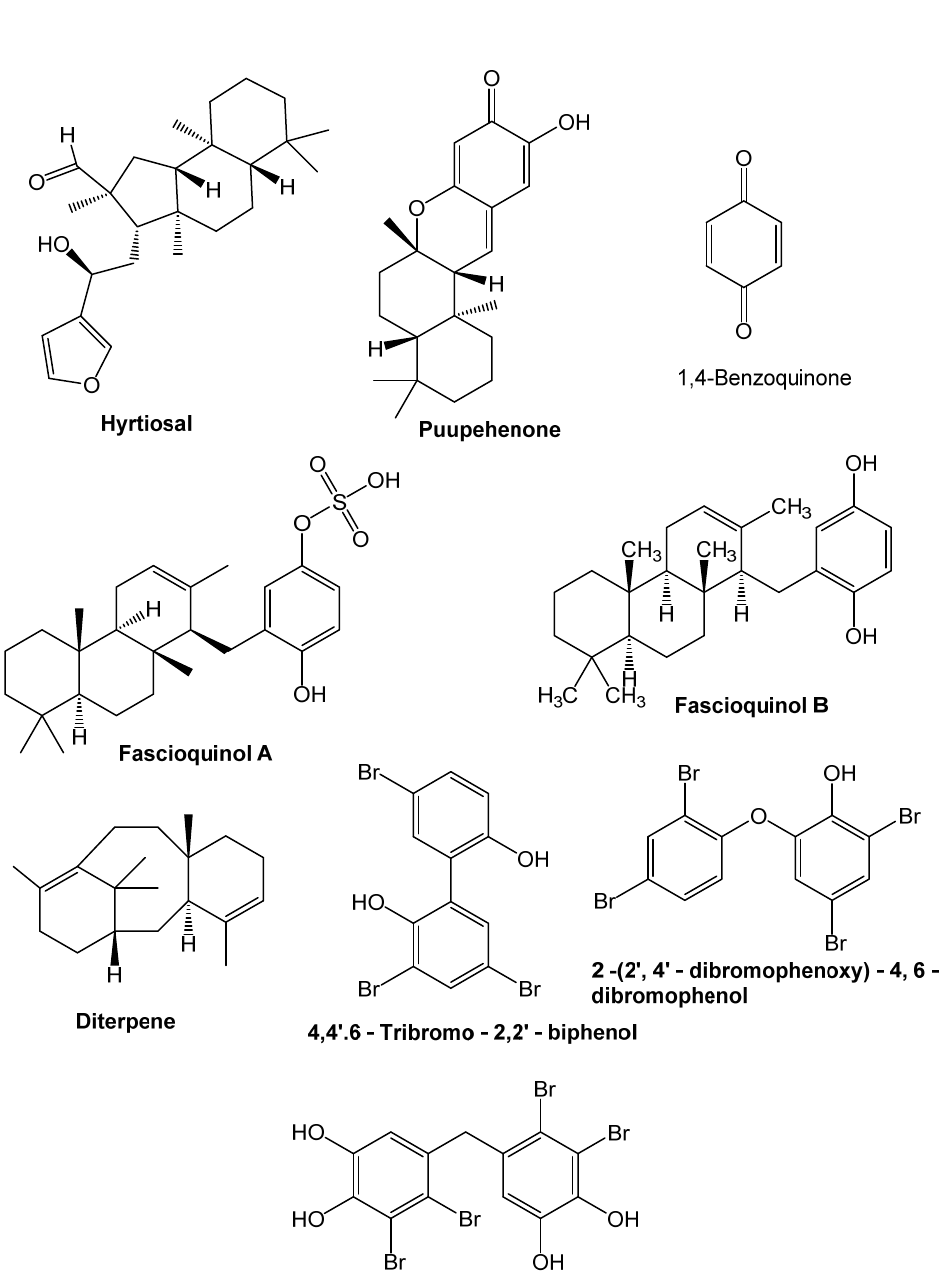
Figure 3. Secondary metabolites presented significant antimicrobial properties from terpenoids and phenolic compounds.